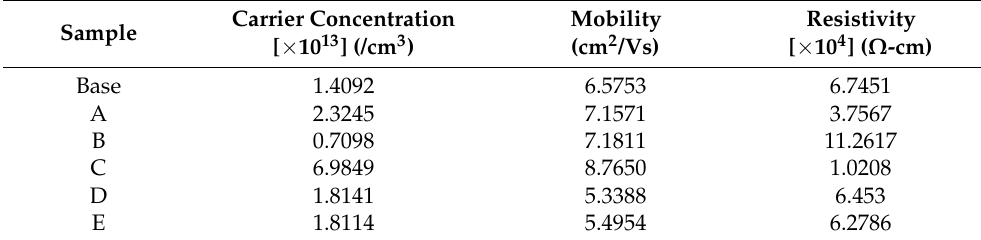
Table 5. Electrical properties of CdTe film for various annealing temperatures.